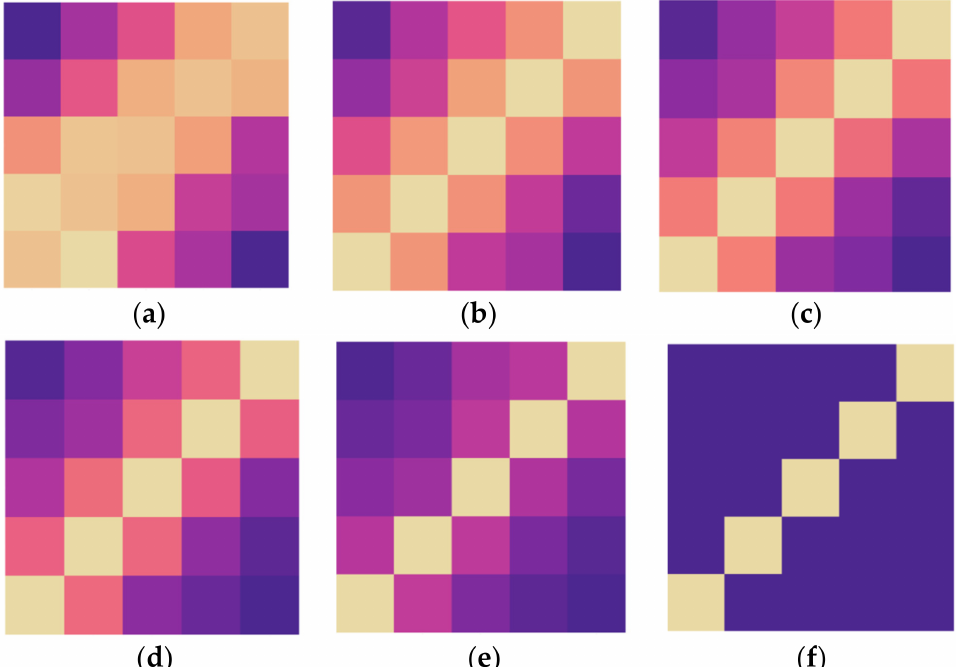
Figure 8. Impact of different layer numbers in the WPGN on classification accuracy: ( a ) layer 0; ( b ) layer 1; ( c ) layer 2; ( d ) layer 3; ( e ) layer 5; ( f ) ground truth.